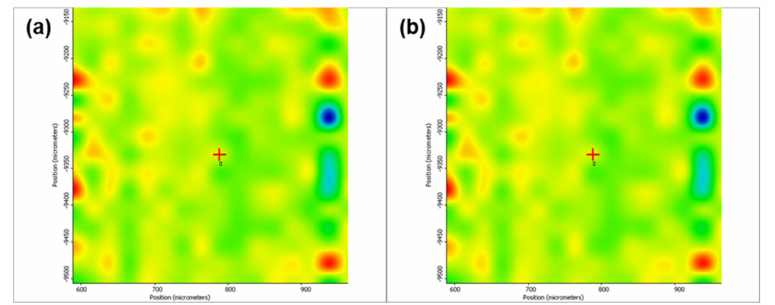
Figure 7. Second derivate IR mappings of Fe 3 O 4 @ β -CD thin films deposited at F = 400 mJ/cm 2 : surface intensity distribution of ( a ) 2930 cm − 1 and ( b ) 1029 cm − 1 .